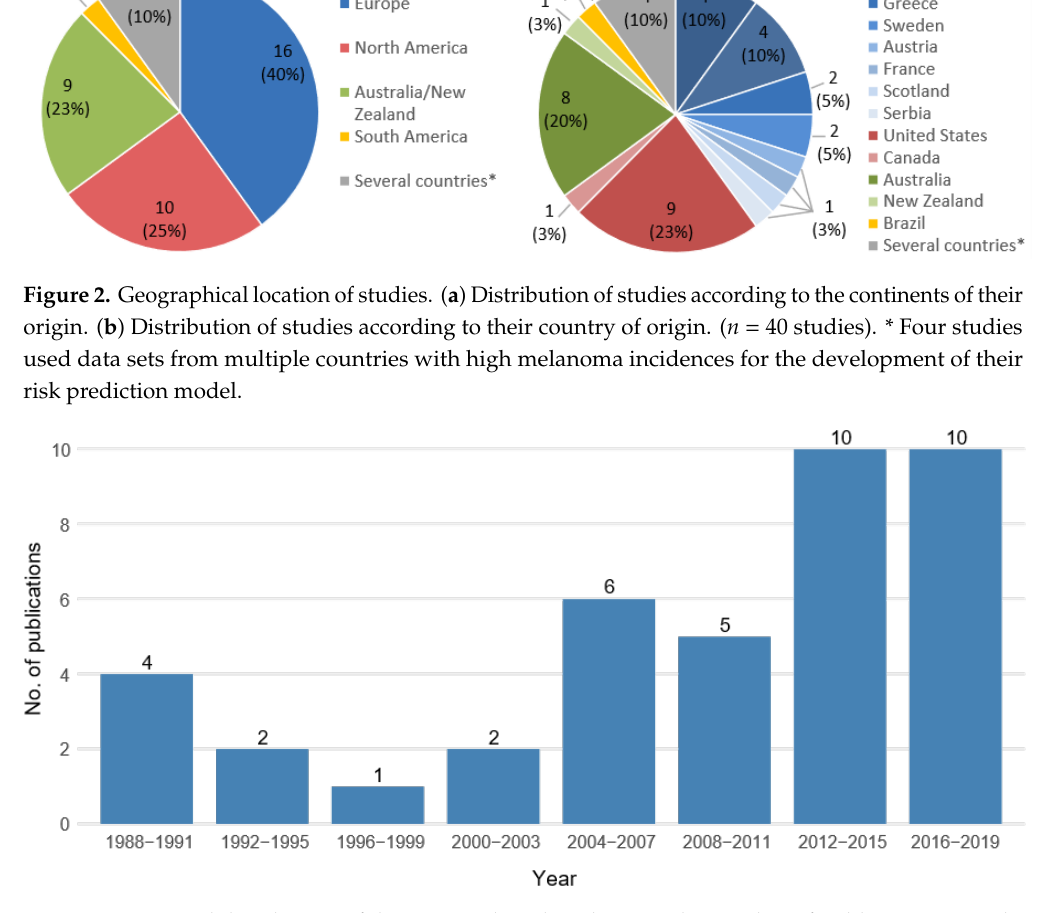
Figure 3. Temporal distribution of the reviewed studies showing the number of publications in eight time intervals of four years each. ( n = 40 studies).